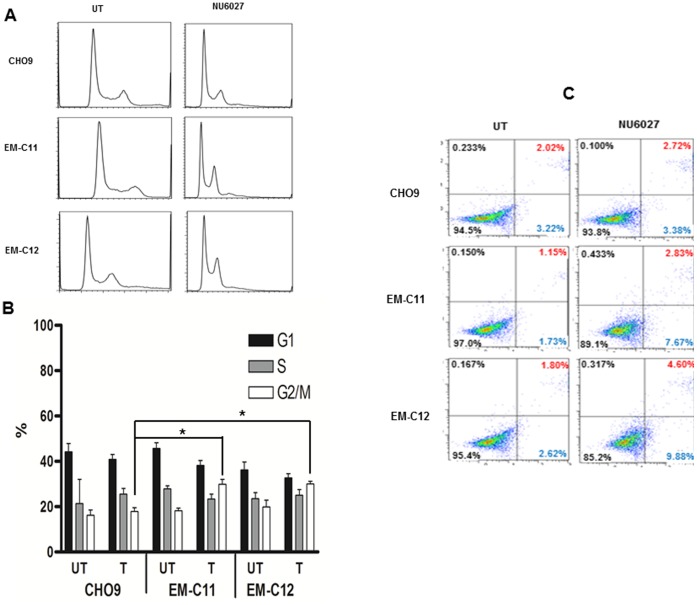
FACS read out in CH cells treated with 24 hours of NU6027 is shown here (A).
B. Quantification of various phases of the cell cycle is shown for CH cell treated with NU6027. Data represent mean values ±SEM (n = 6). Results were analysed using Students t-test. * p<0.05. C. FITC-Annexin V apoptosis assay is shown here. The proportion of cells in early phase apoptosis is higher in XRCC1 deficient cells treated with NU6027 compared to wild type cells.